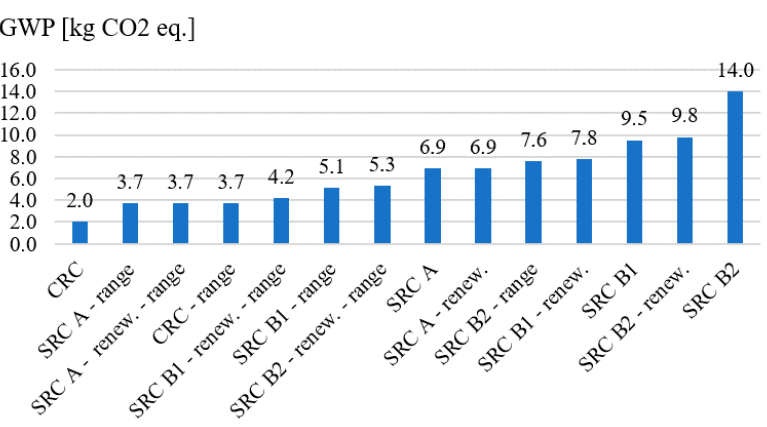
Figure 5. Concrete demolition range—depending on the grain size and process used.